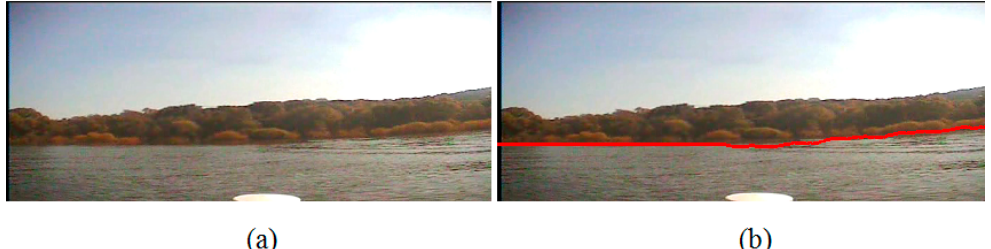
13 of 18 Figure 15. Waterline detection of a far bank. ( a ) The image before our detection; ( b ) The image after our detection. Figure 16. Waterline detection of a far bank and a distant mountain. ( a ) The image before our detection; ( b ) The image after our detection. Figure 17. Waterline detection of a closer bank with uneven illumination. ( a ) The image before our detection; ( b ) The image after our detection.